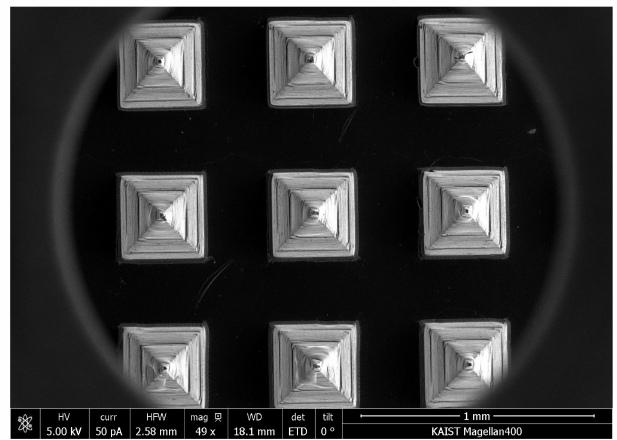
Figure 9. SEM image of HBsAg MN after the application on mouse